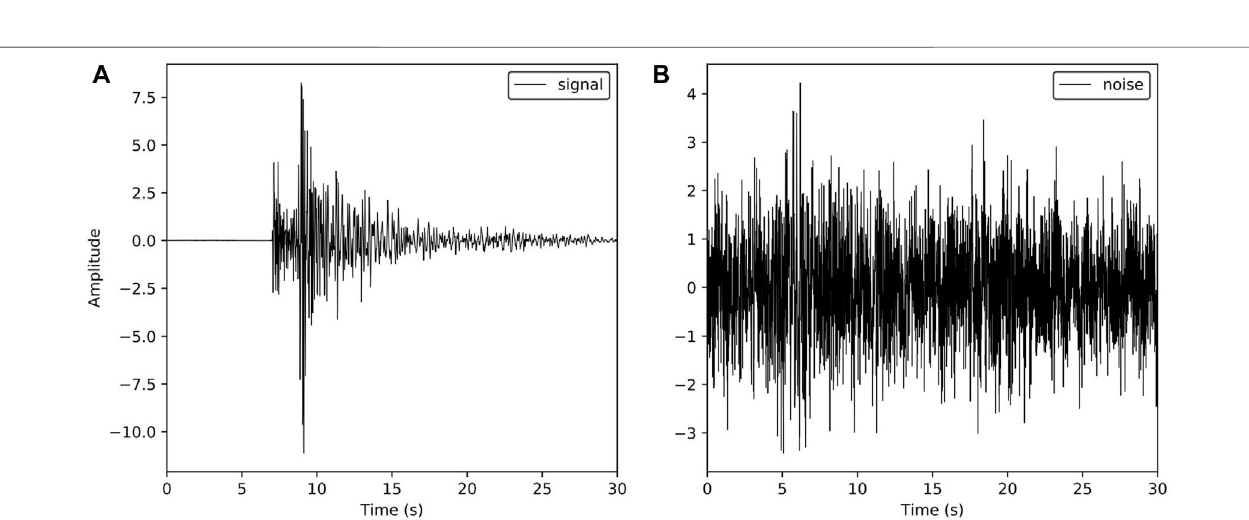
FIGURE 13 | High SNR seismic signal and noise signal waveform; (A) seismic signal; (B) noise waveform.